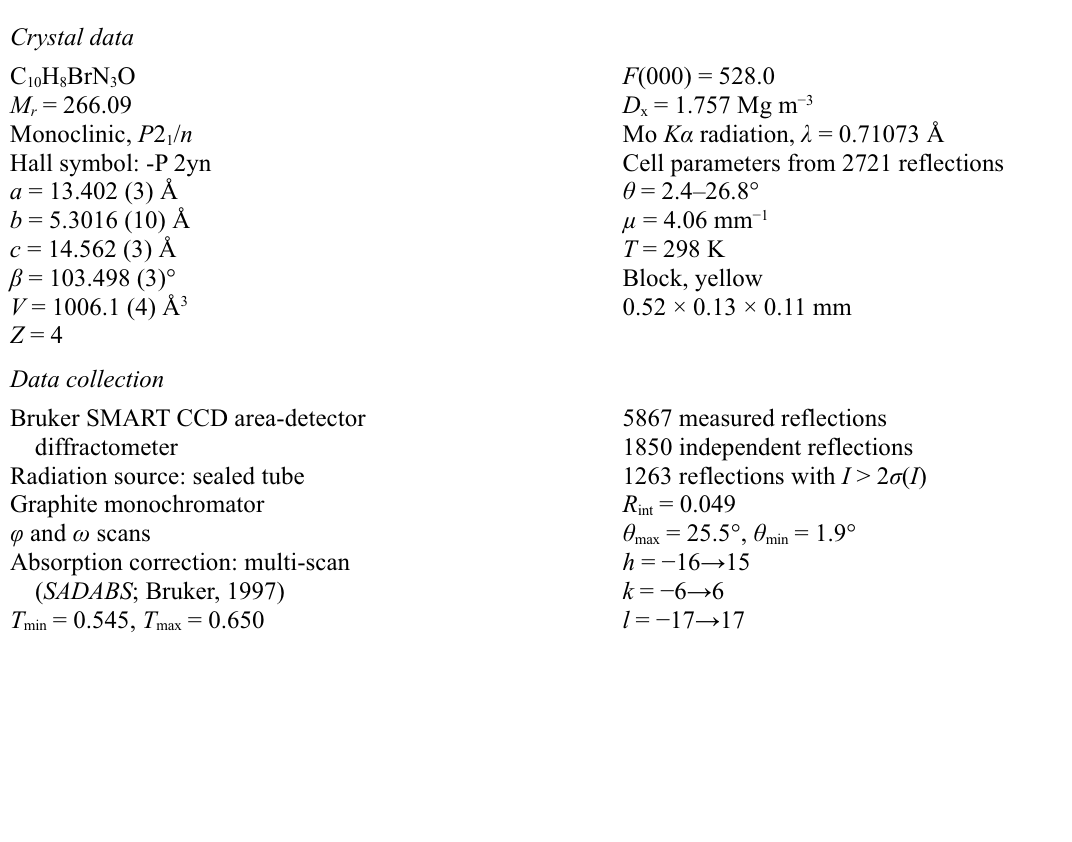
Crystal structure of the title compound, viewed along the c axis. Hydrogen bonding is shown as dashed lines. 2-[(6-Bromo-2-pyridyl)amino]pyridine